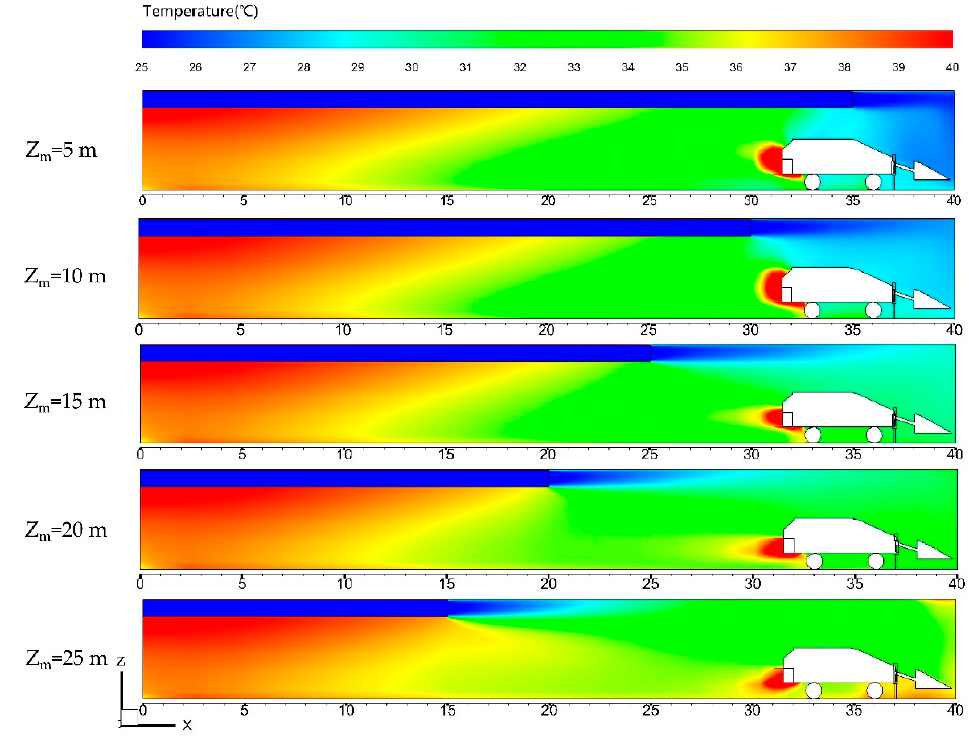
Figure 15. Airflow temperature distributions in plane A when Z m = 5 m, Z m = 10 m, Z m = 15 m, Z m = 20 m, and Z m = 25 m.